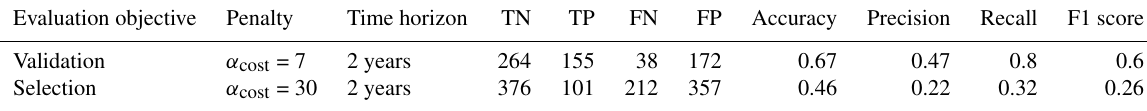
Table D1. Performance of the algorithm without preprocessing on 2-year